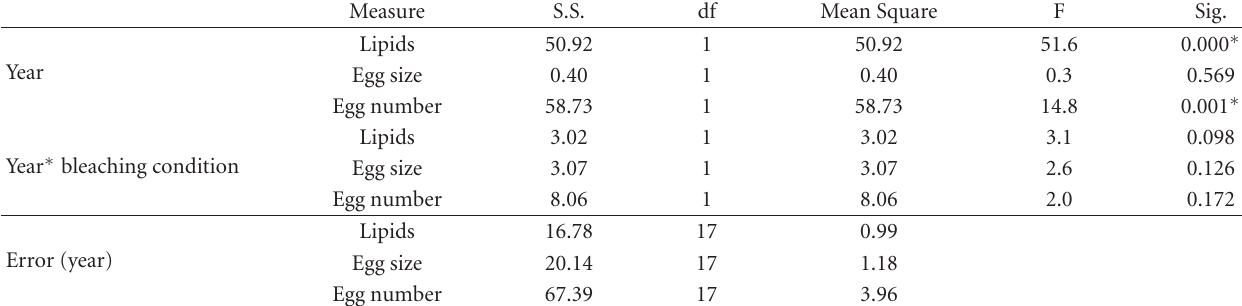
Table 6: The results of a multivariate ANOVA showing the significant within-subject e ff ect of year on the lipids and egg numbers in bleached C2 and unbleached D colonies of Acropora millepora before and after a bleaching event in February 2006. There was no significant e ff ect of year on egg size and no significant interactions between bleaching condition and year. ∗ indicate significant